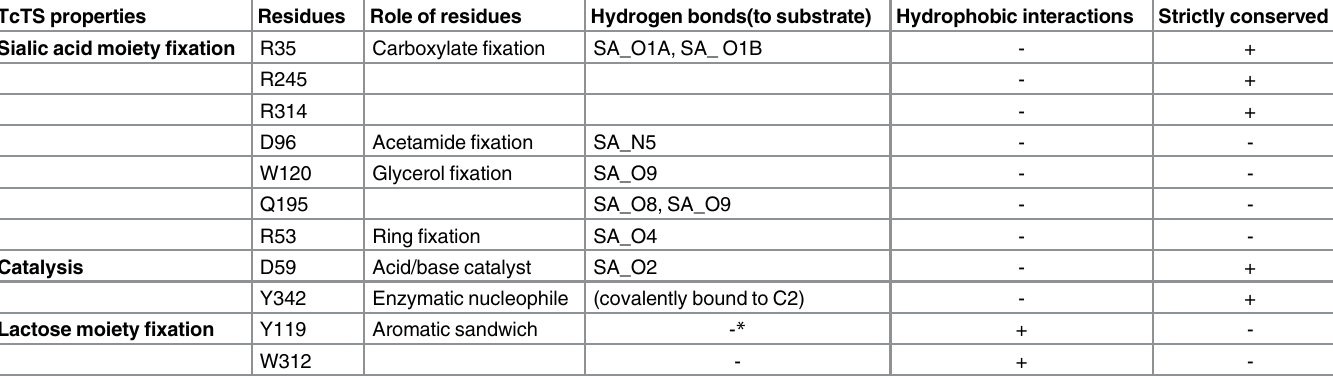
Table 1. Summary of the interactions between TcTS and 3 ’ -sialyllactose in the Michaelis complex; SA is sialyl [11, 24]. TcTS